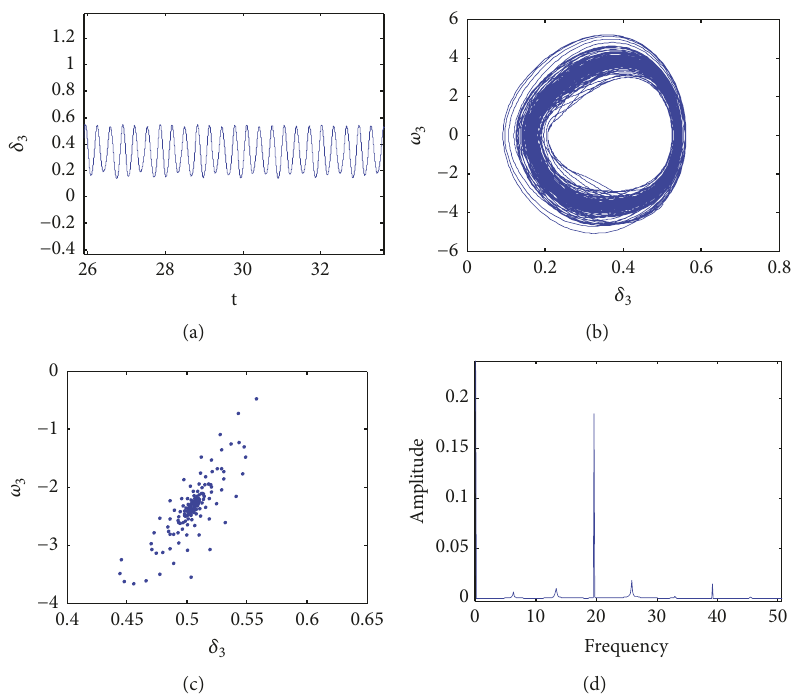
Figure 19: Quasi-periodic motion ( 𝑉 𝐵1 = 0.6). (a) Time history. (b) Phase portrait. (c) Poincar´e map. (d) Frequency spectrum.